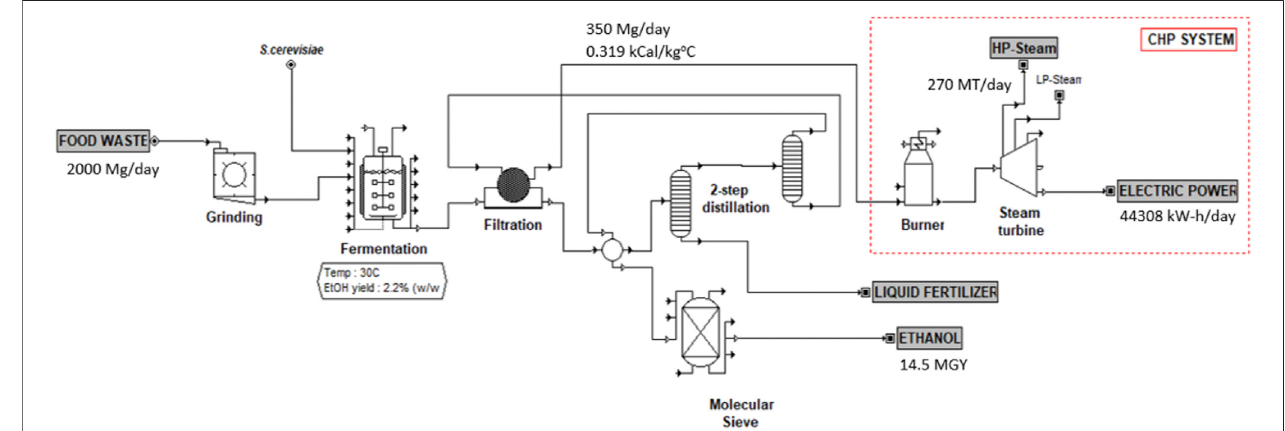
FIGURE 3 | Process fl ow diagram of FW fermentation with integrated CHP.